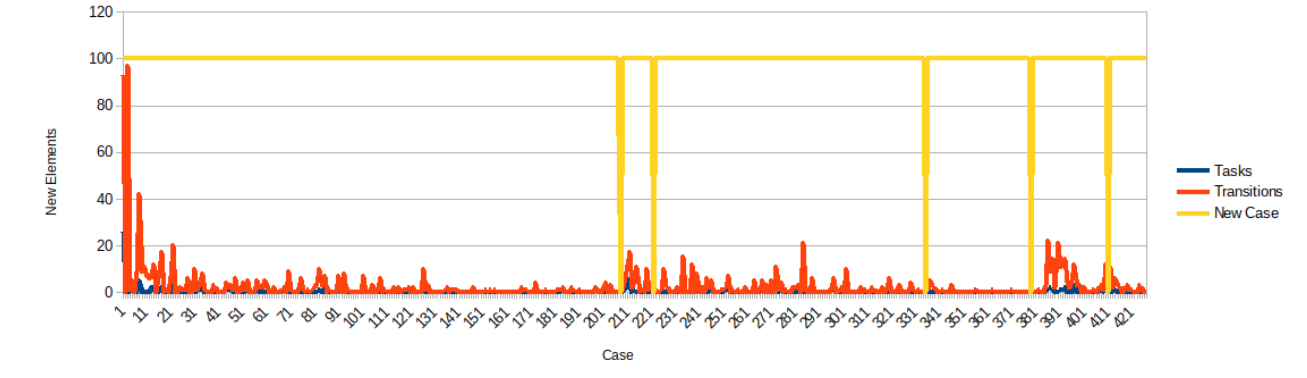
Figure 3. Trend in incremental prequential process model learning for all